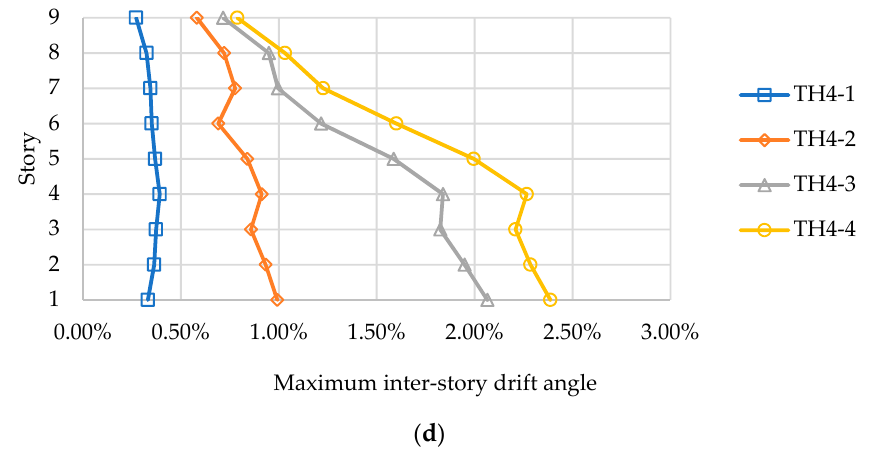
Figure 13. Maximum response envelopes of inter-story drift under ( a ) GM 1; ( b ) GM 2; ( c ) GM 3; and ( d ) GM4.